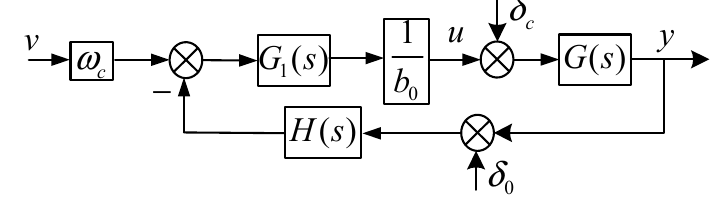
Figure 8. Equivalent system structure diagram.